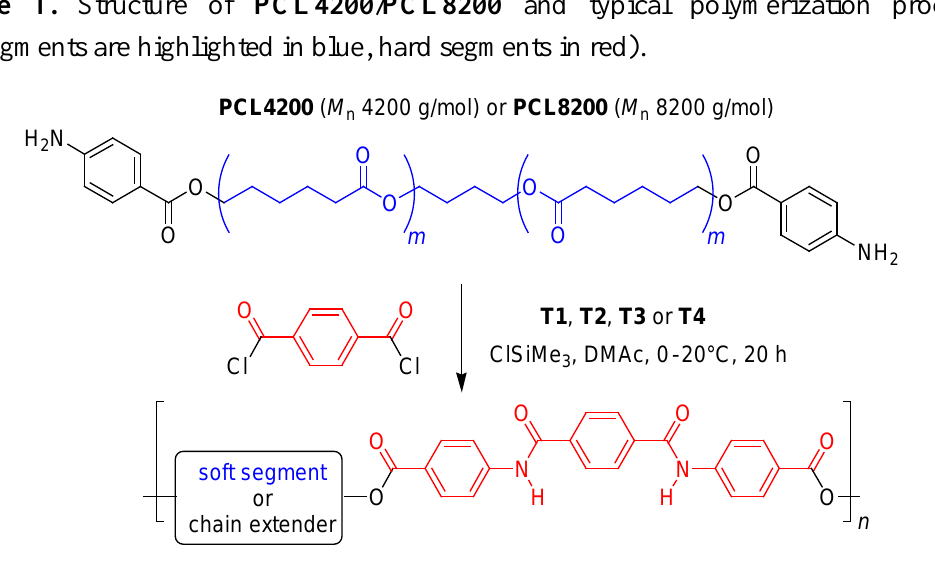
Scheme 2. Structures of short-chain telechelics T1 – T4 (“chain extenders”) used in copolymerizations.